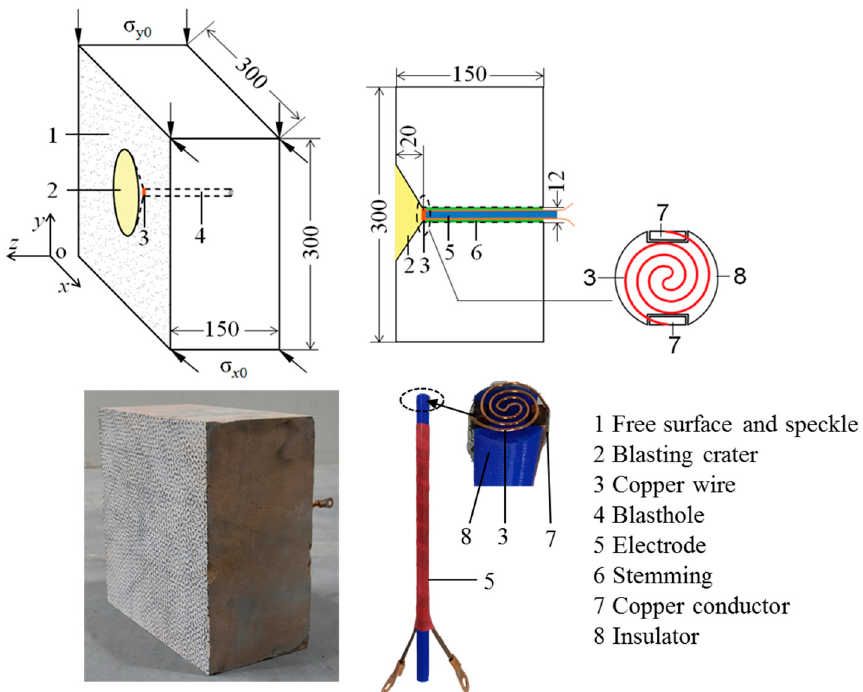
Figure 2. Schematic and photo of the sandstone specimen (unit: mm).